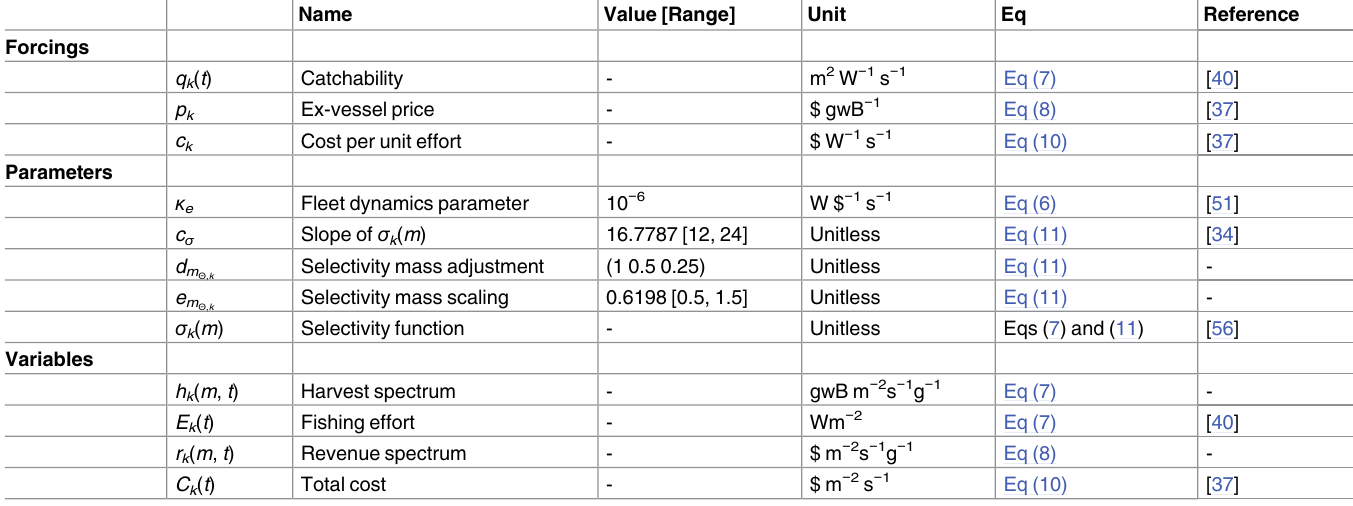
Table 2. Economic forcings, parameters and